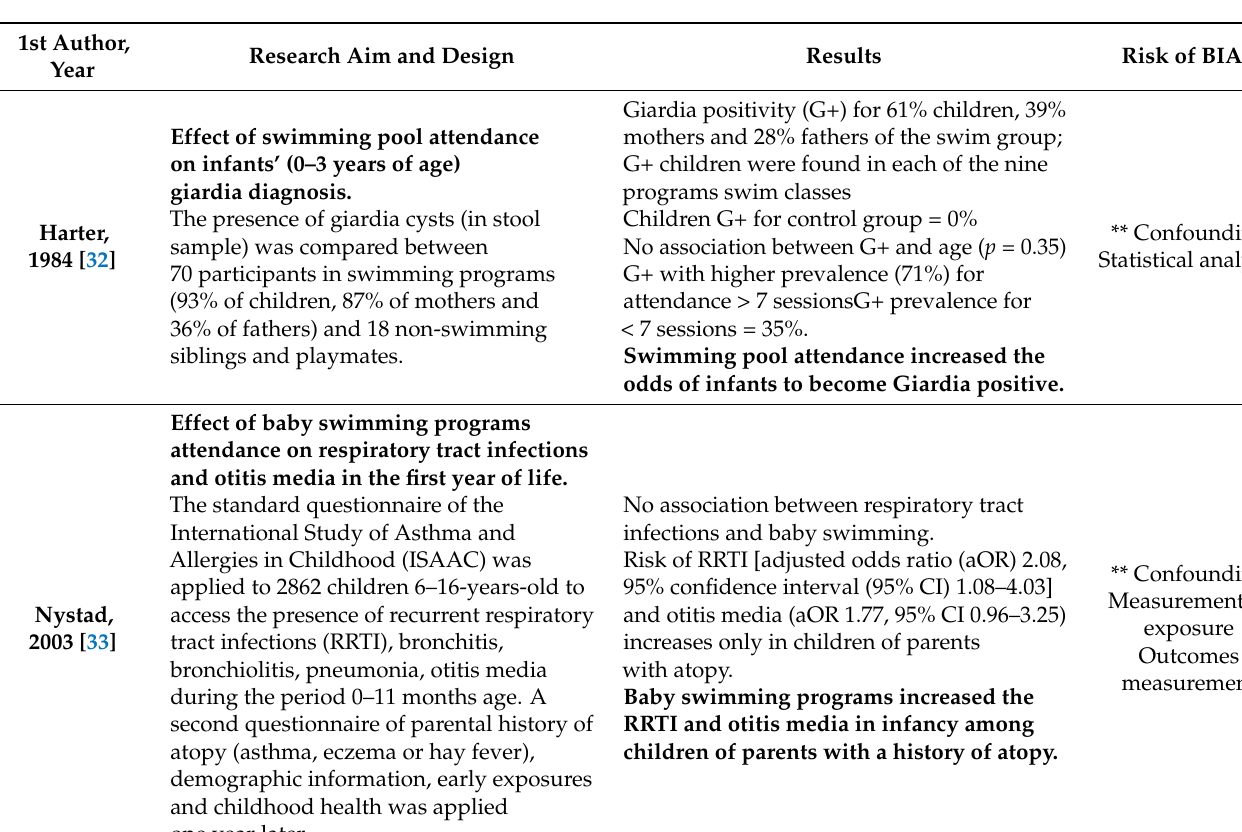
Table 2. Effects of exposure to baby swimming programs on infants’